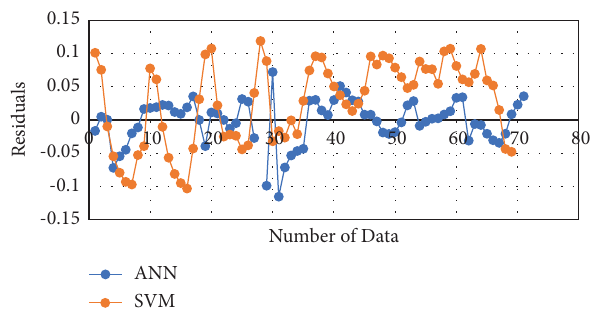
Figure 11: Residual distributions for ANN and SVM models for predicting G ∗ .